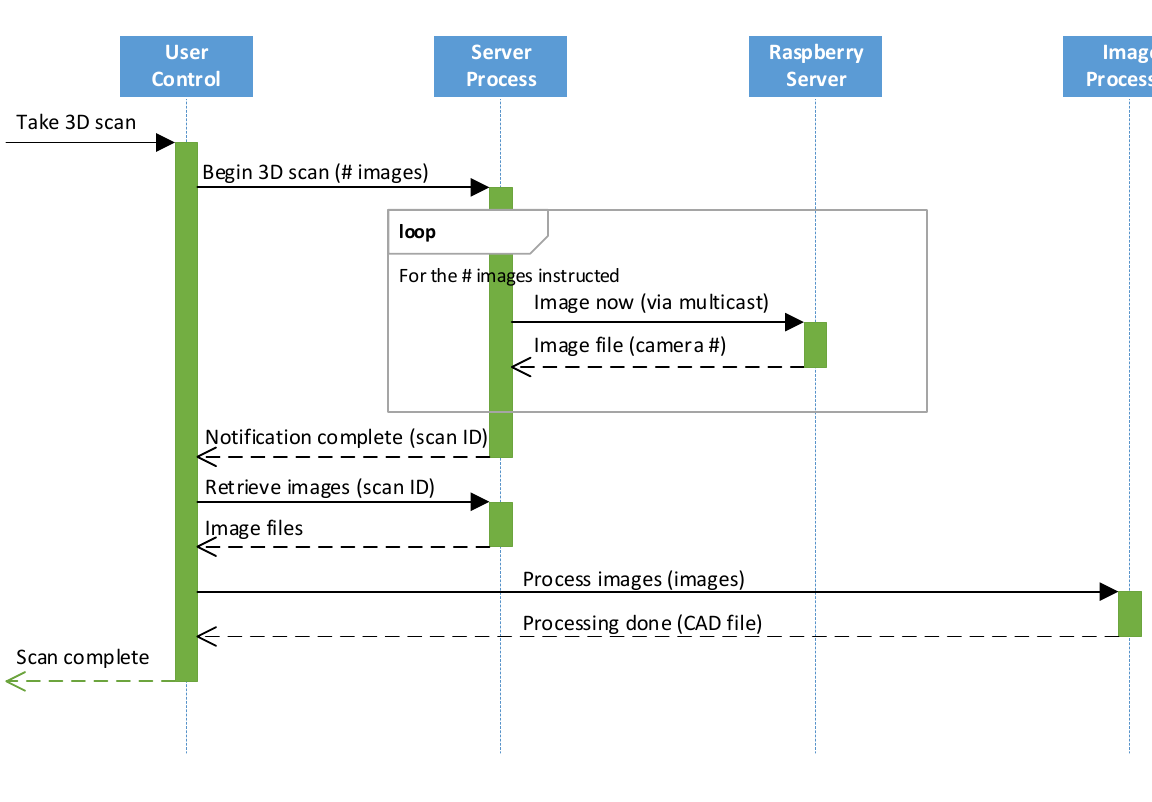
Figure 6. UML sequence diagram of software